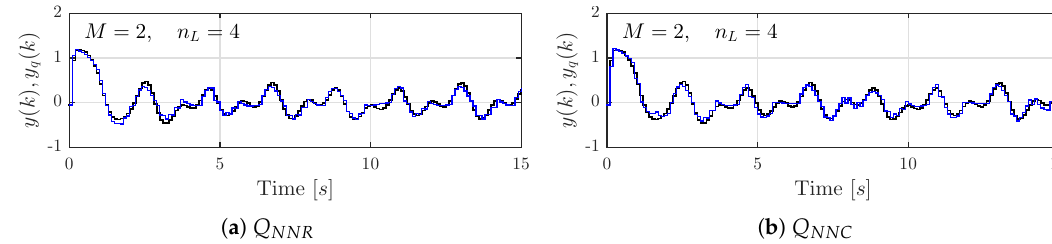
Figure 8. Output signals y q ( k ) (blue) and y ( k ) (black) resulting from applying u ( k ) to the error system with Q NN designed for M = 2 and n L =